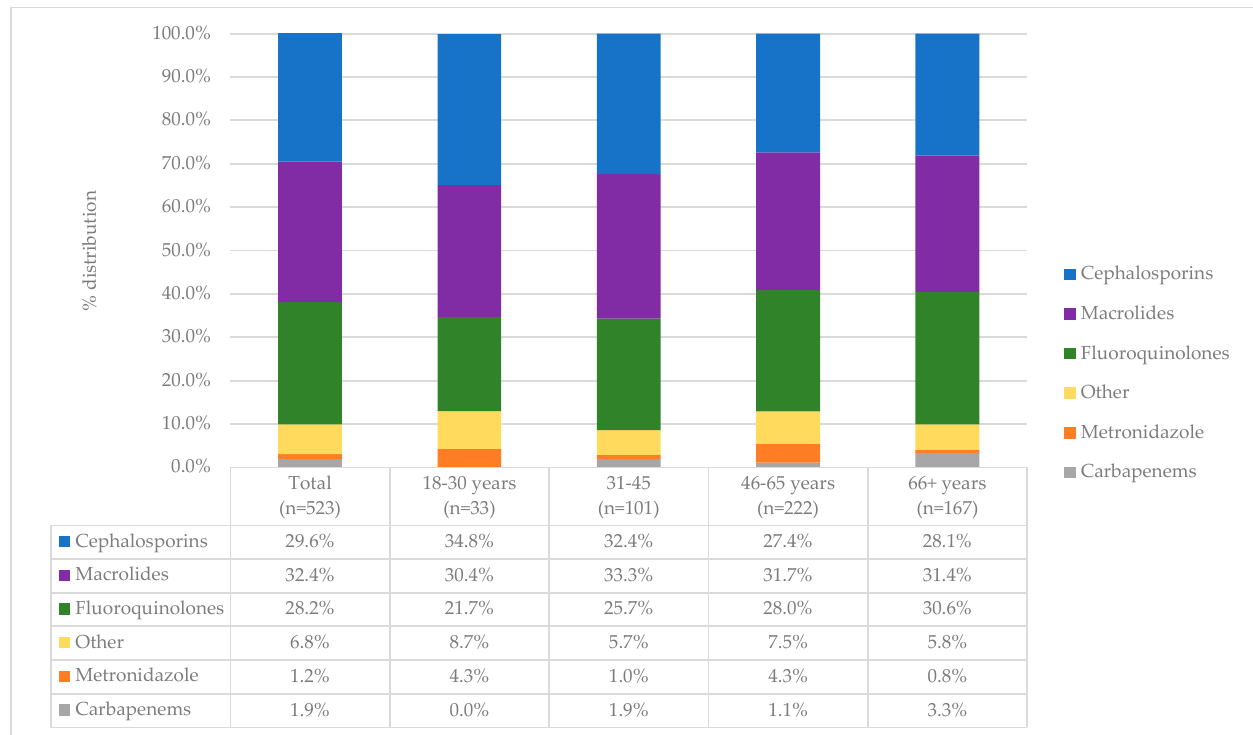
Figure 2. Pre-admission profile of antibiotics used across major age groups . Various patient characteristics at admission were analysed in relation to prior antibi- otic use. Associations with a longer duration of illness at admission (8.8 ± 5.3 vs. 5.7 ± 3.7, p < 0.001), a more frequent use for oxygen therapy upon admission (27.6% vs. 16.0%, p =